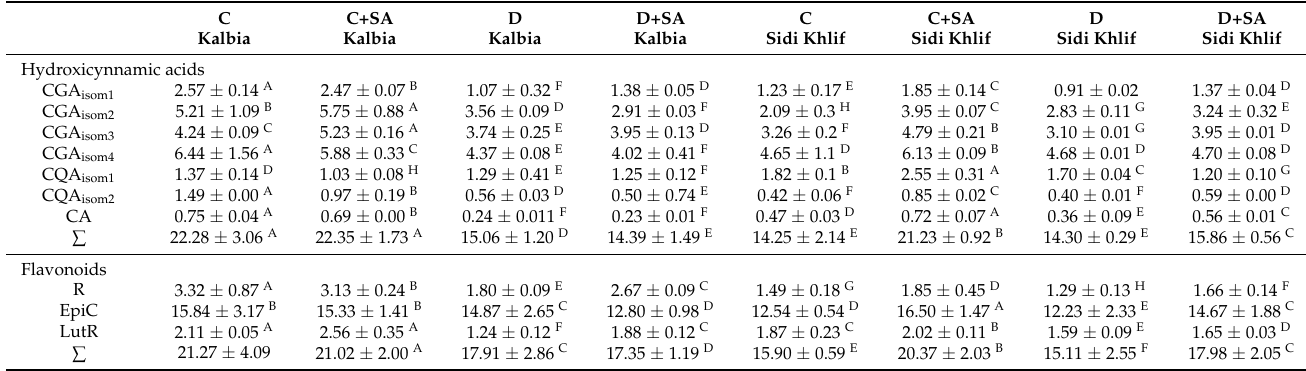
Table 5. Contents of individual phenolic compounds (mg/g DW) in Sulla carnosa leaves of Kalbia (KA) and Sidi Khlif varieties, primed with salicylic acid (SA) and grown under different Fe concentrations for 8